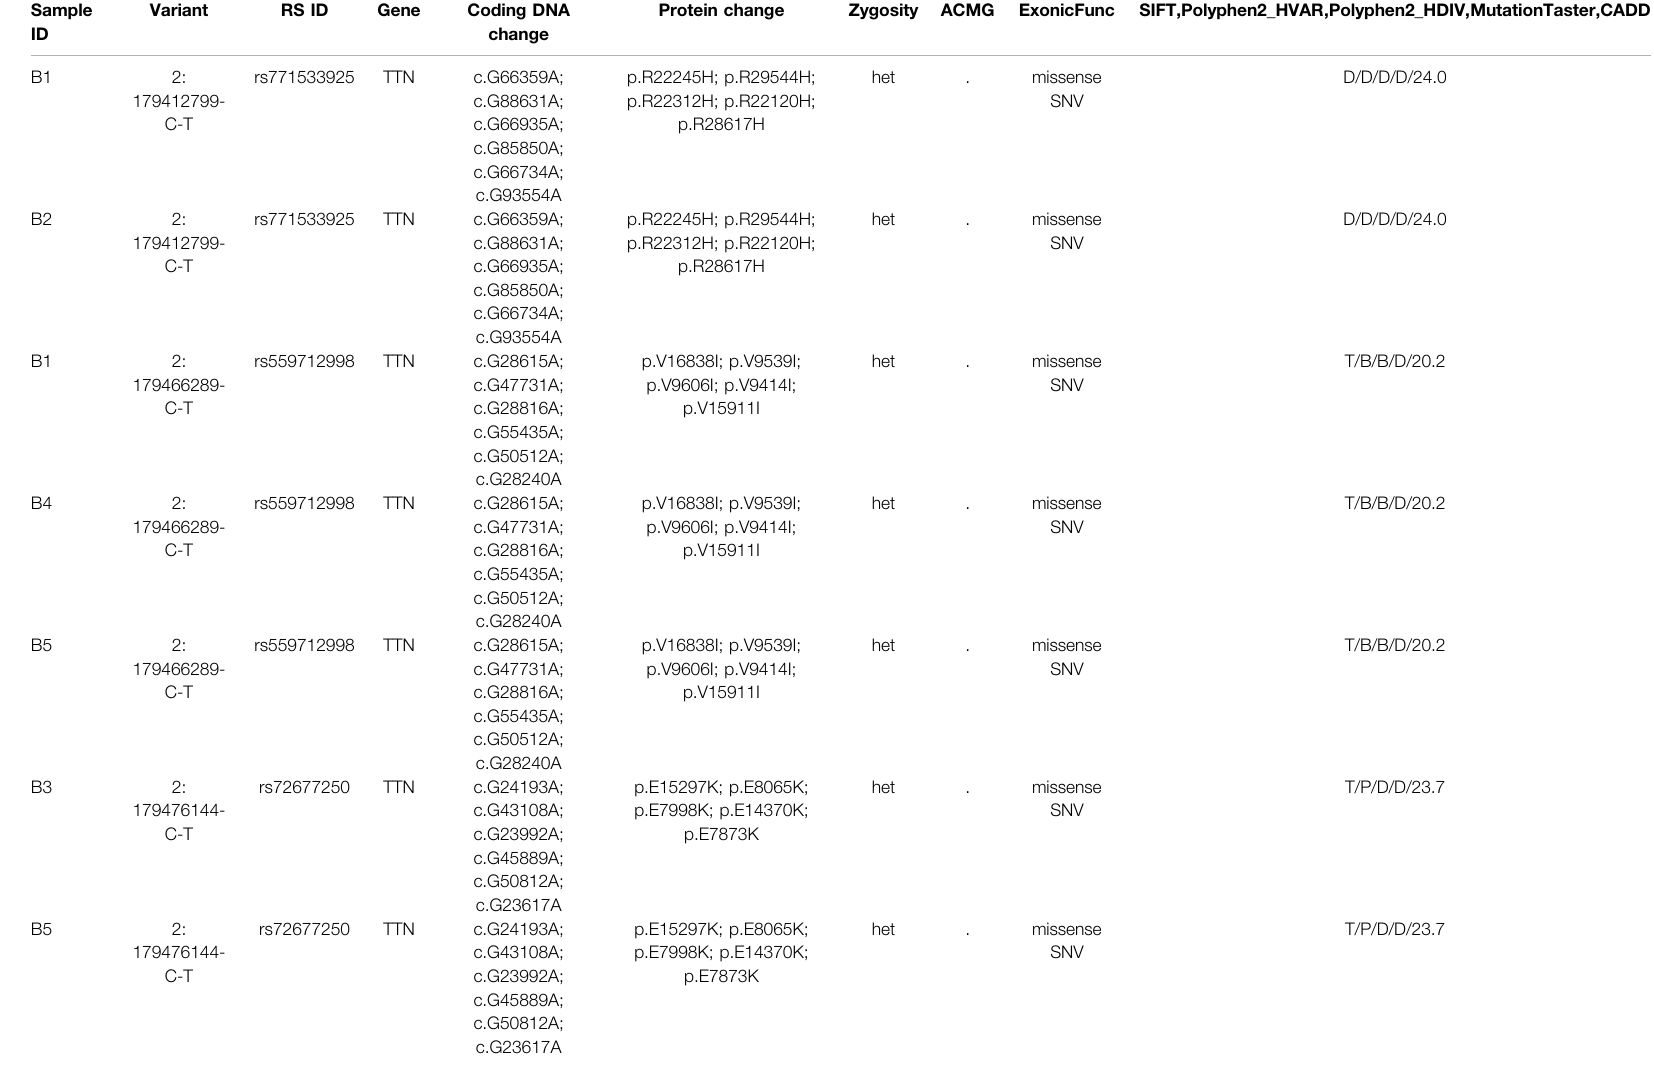
TABLE 2 | The detailed information of point mutation